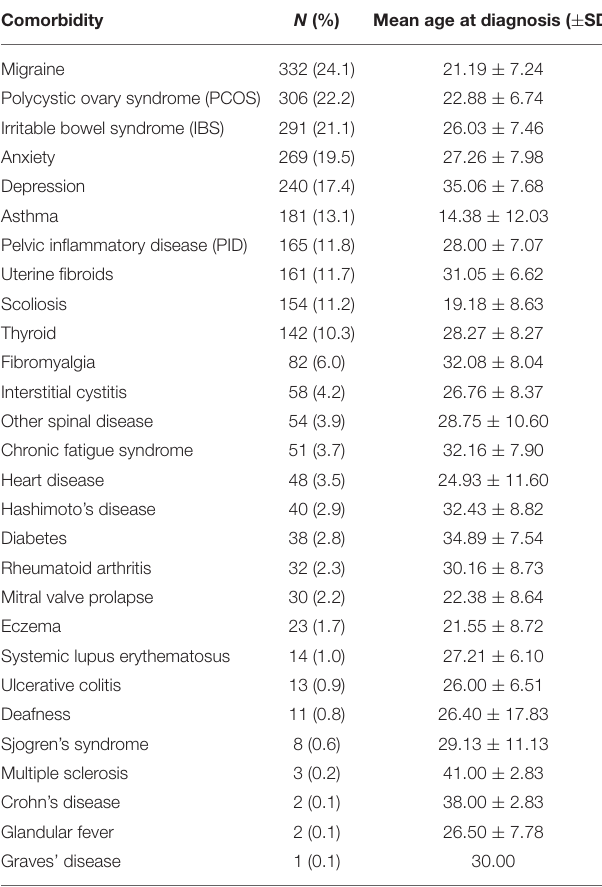
TABLE 3 | Most common comorbidities reported by endometriosis patients from Ibero-America. Comorbidity N (%) Mean age at diagnosis ( ± SD) Migraine 332 (24.1) Polycystic ovary syndrome (PCOS) 306